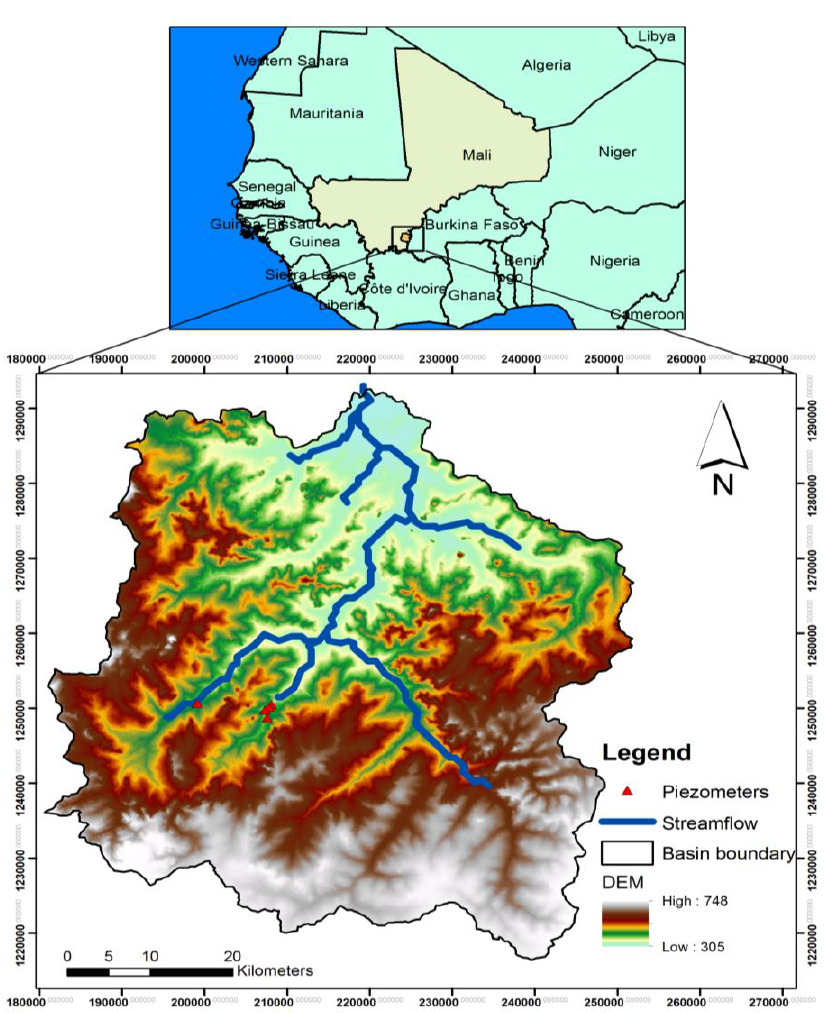
Figure 1. Geographical location of the Klela Basin in southern Mali.